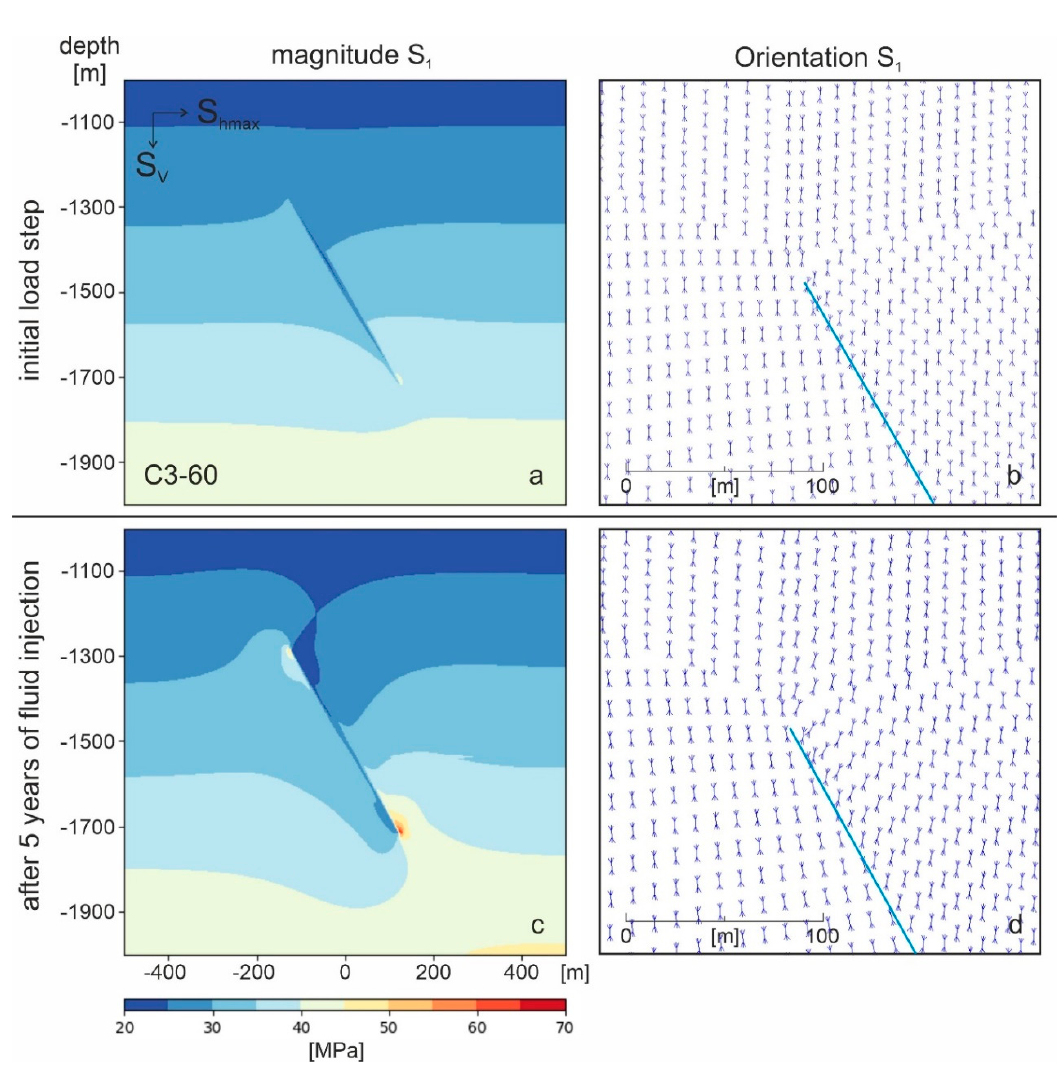
Figure 6. Results of the base model (C3-60). Initial state: ( a ) magnitude of the maximum principal stress (S 1 ) for the whole model domain. ( b ) detailed view of the orientation S 1 in the vicinity of the upper fault tip. After 5 years of injection: ( c ) magnitude S1 for the whole model domain. ( d ) detailed view of the orientation S 1 in the vicinity of the upper fault tip.